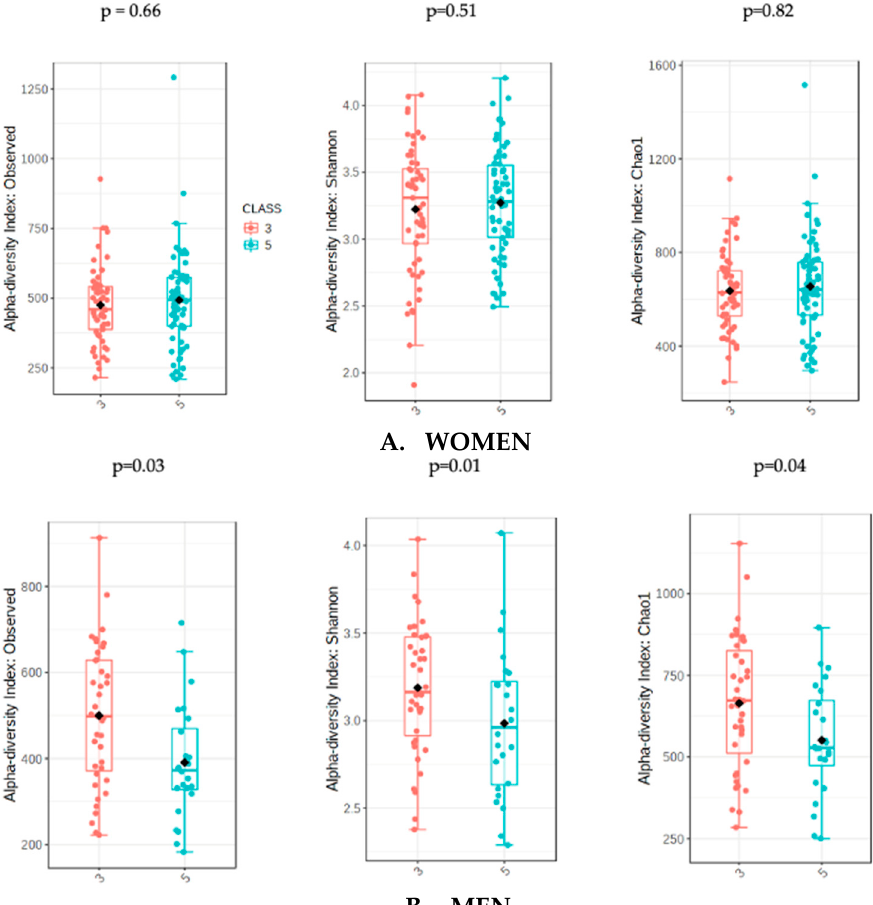
Figure 1. Richness measured as observed counts (left), Shannon diversity (middle) and Chao1 index (right), categorized according to the consumption of UPFs adjusted by BMI, age and energy intake for women ( A ) and men ( B ). Men who consumed more than 5 UPFs showed significantly lower richness and alpha diversity. Orange boxes represent women ( A ) and men ( B ) who consumed less than 3 serv/d of adjusted UPFs, and blue boxes represent the group that consumed more than 5 serv/d of adjusted UPFs.